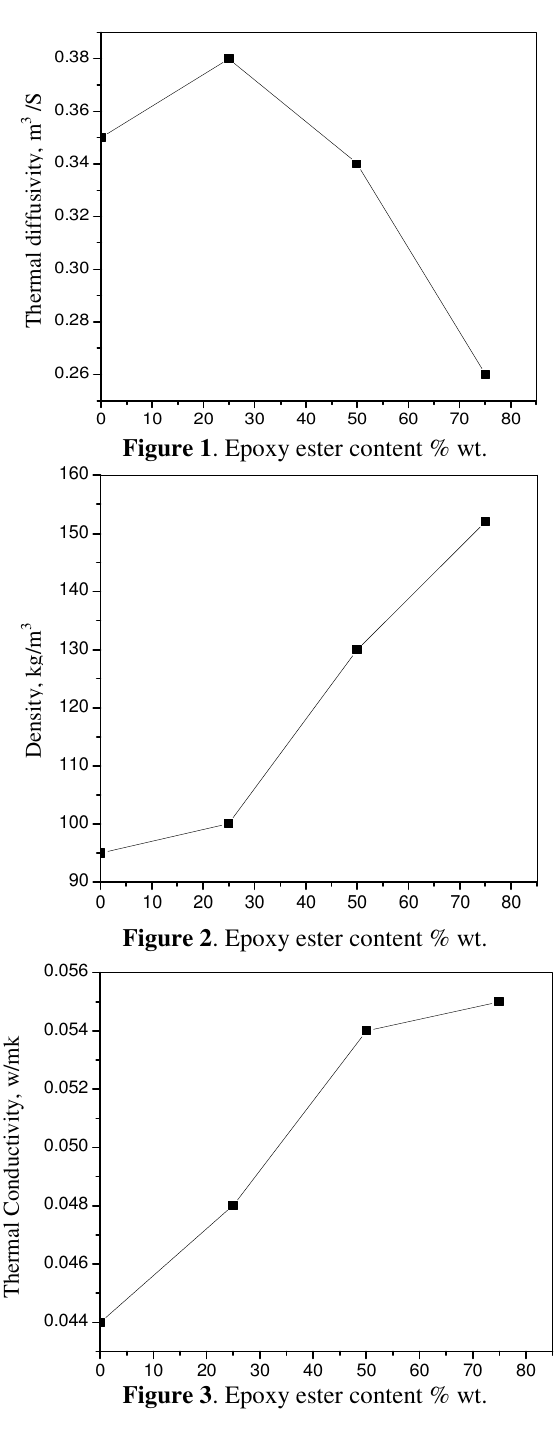
Figure 3 . Epoxy ester content %